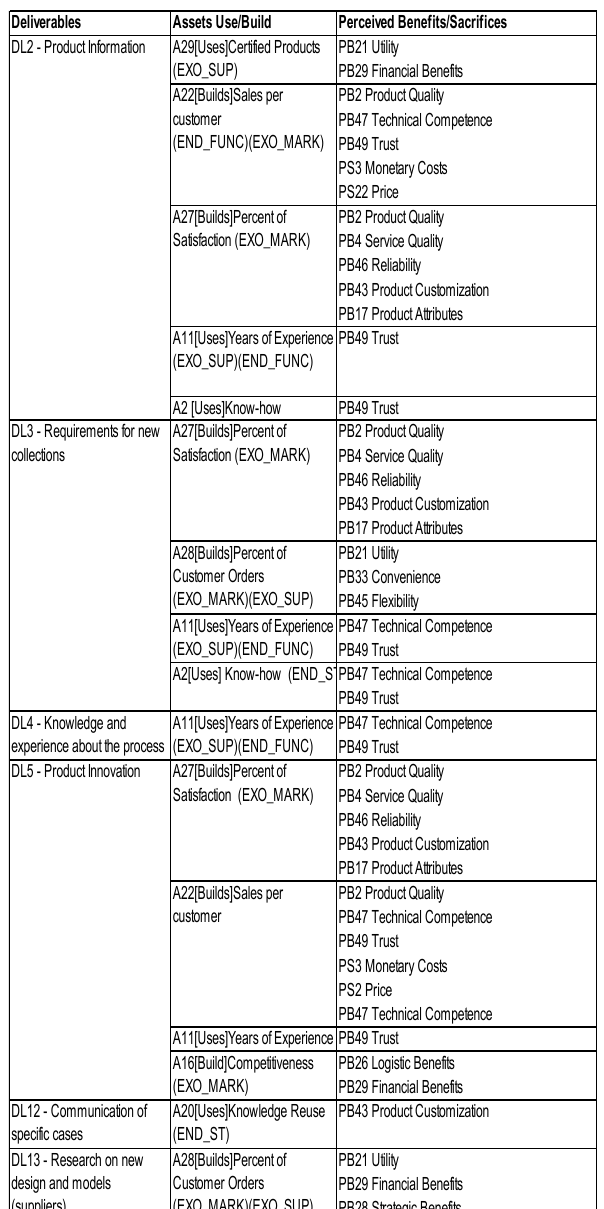
Table A.1. Perceived